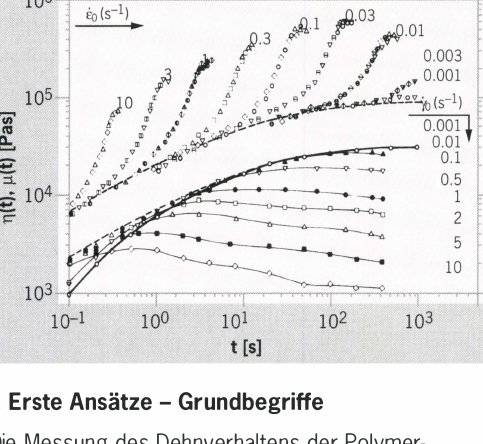
Fig. 2: Recoverable portion £R of the total elongation A of the polyethylene melt shown in Fig. 1; temperature: